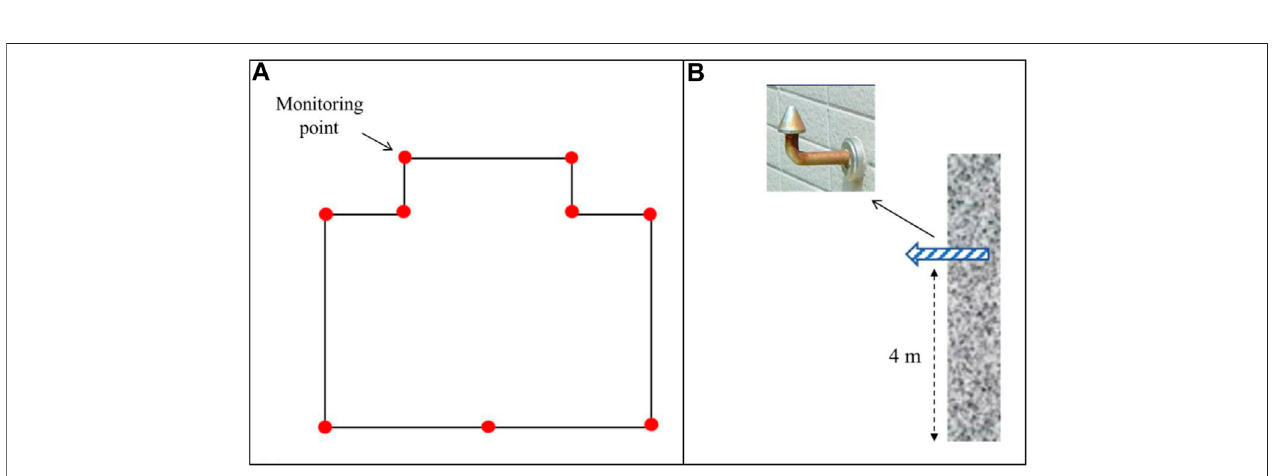
FIGURE 4 | Data collection process of foundation settlement.